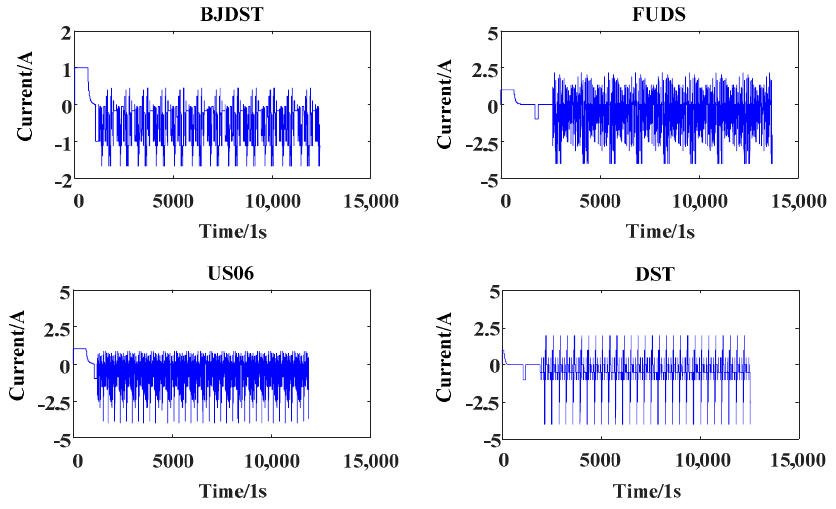
Figure 5. Current profiles measured in the Beijing Dynamic Stress Test (BJDST), the Federal Urban Driving Schedule (FUDS), US06, and the Dynamic Stress Test (DST).